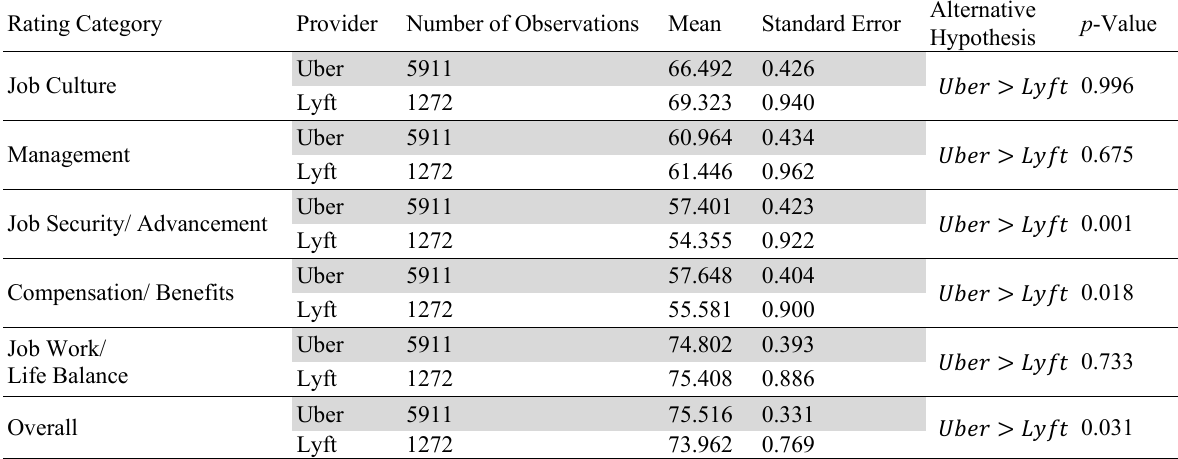
Summary of Descriptive Statistics and Statistical Tests